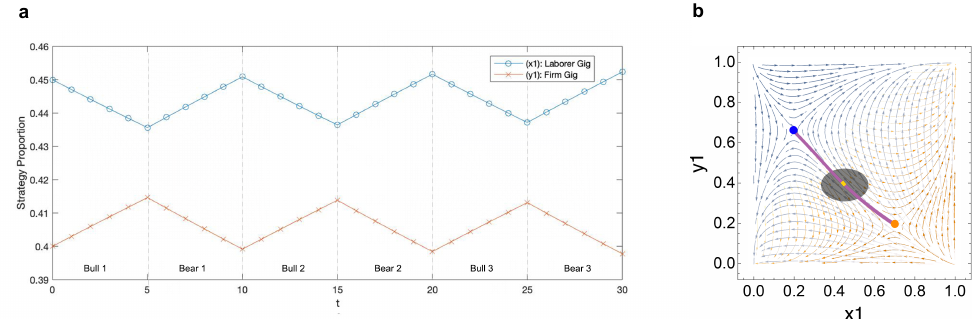
Figure A3. Trapping zone oscillation with initial conditions ( 0.45,0.40 ) , ω = 0.005 and n = 1 and theoretical GameState pair, see Figure 1. ( a ) Mismatching oscillatory behavior in trapping zone. ( b ) Trapping zone orbit. We illustrate the trapping zone orbit in yellow. A reference attractor arc is plotted in purple and attractor positions at n = 0 and n = 1 are represented in orange and blue, respectively. The opaque black ellipse is a background element for visual contrast.